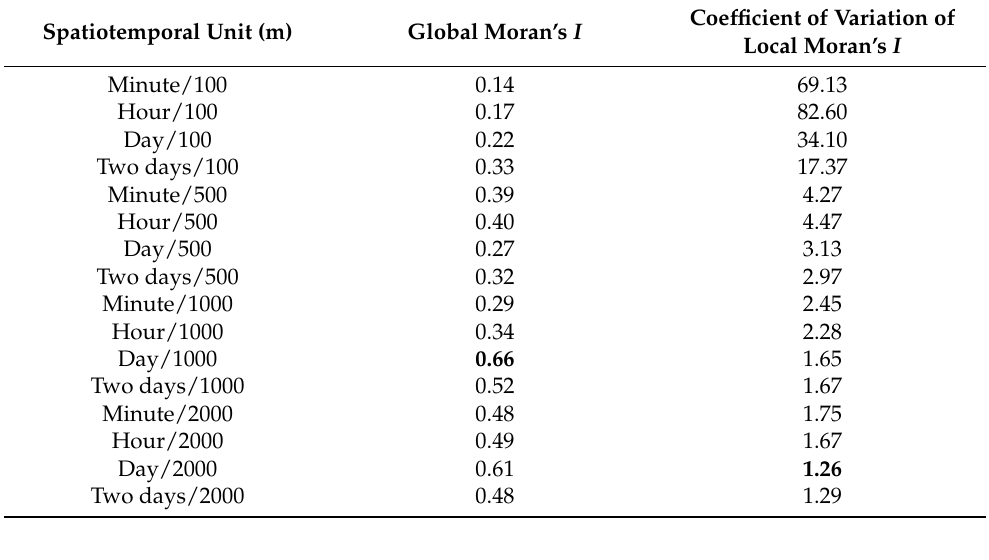
Table 2. Global spatial correlation and local spatial stability.